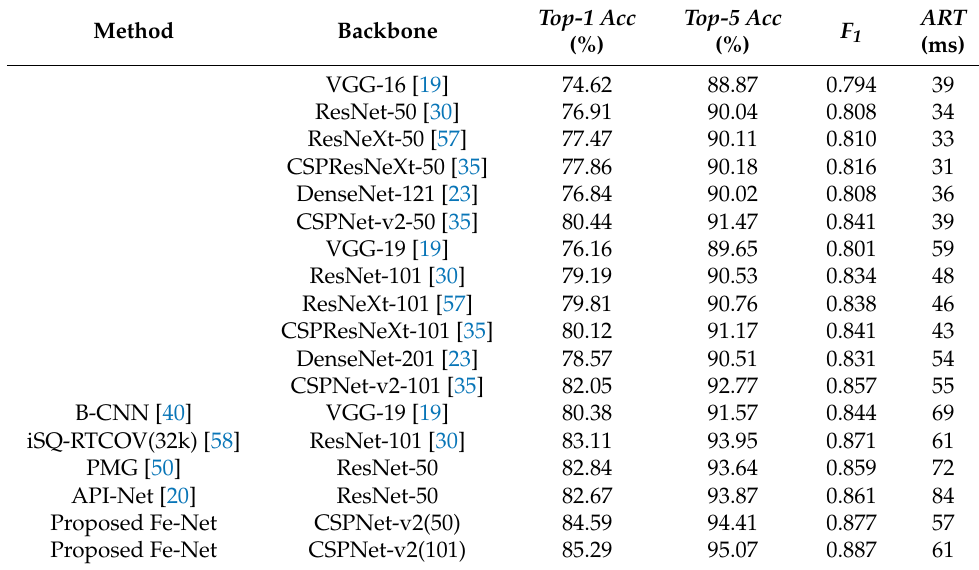
Table 1. Comparison experimental results on CropDP-181